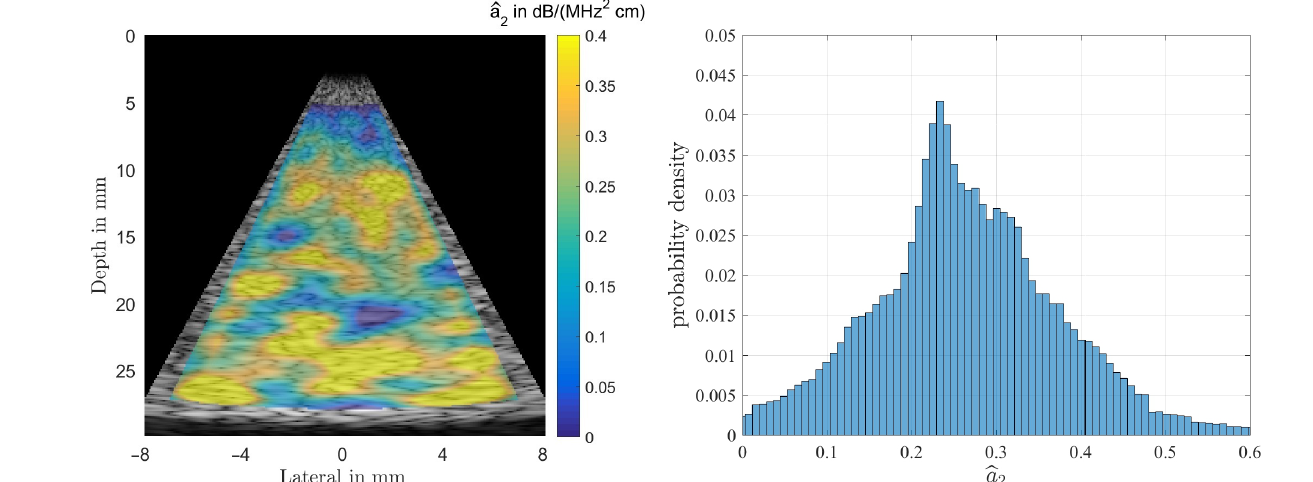
Figure 8. Result of estimating (cid:98) a 2 from simulations of the homogeneous phantom ( left ). The true value is a 2 = 0.2, and the histogram for (cid:98) a 2 ( right ). One can observe a rather large spread thus rendering the estimate to be of limited use in